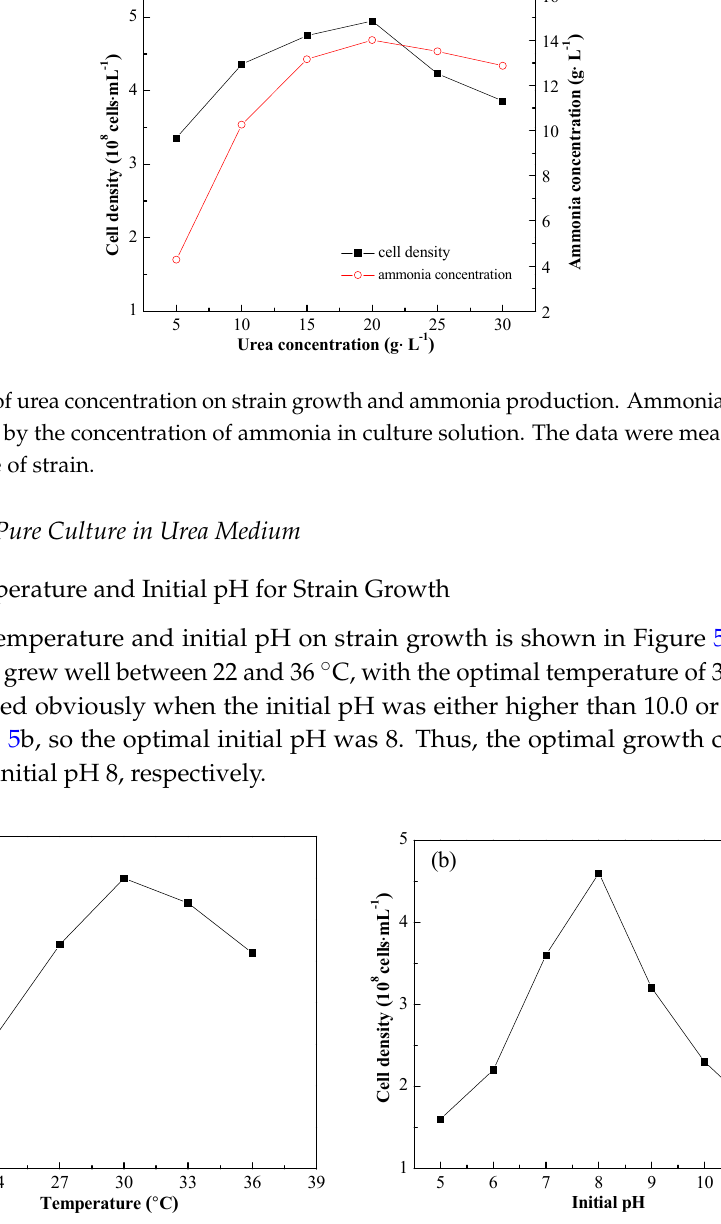
Figure 5. Effect of temperature ( a ) and initial pH ( b ) on strain growth. The cell densities were measured at the stationary phase of strain.